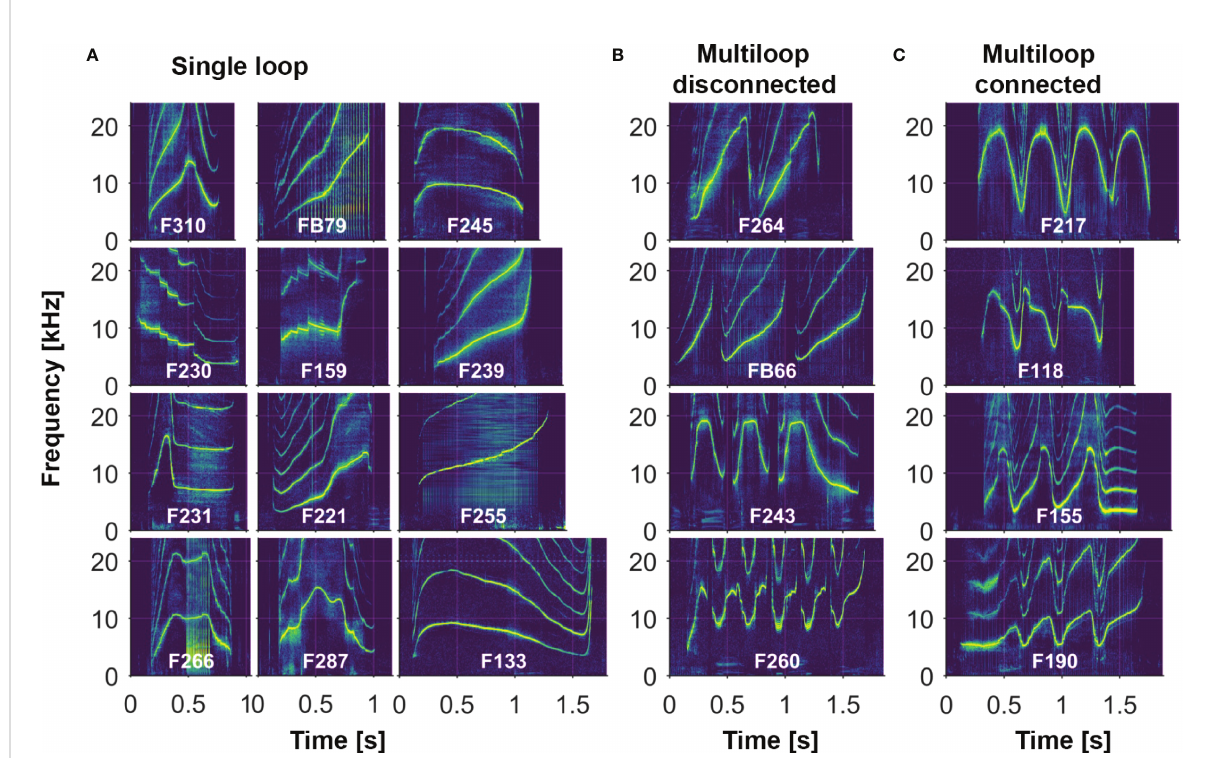
FIGURE 2 Examples of different whistle contour types from a subset of Sarasota dolphins (see text for more detail; labels represent animal identi fi cation numbers): (A) Single-loop whistles consist of a single, non-repeated element. (B, C) Multi-loop whistles consist of variable numbers of repetitive elements, which can be disconnected (B) or connected (C) . Shown here are examples of multi-loop whistles with identical loops (F264, F217), different introductory loop (FB66, F118), different terminal loop (F243, F155), and different introductory and terminal loops (F260, F190). [Note also the presence of steps in the contours of F230 and